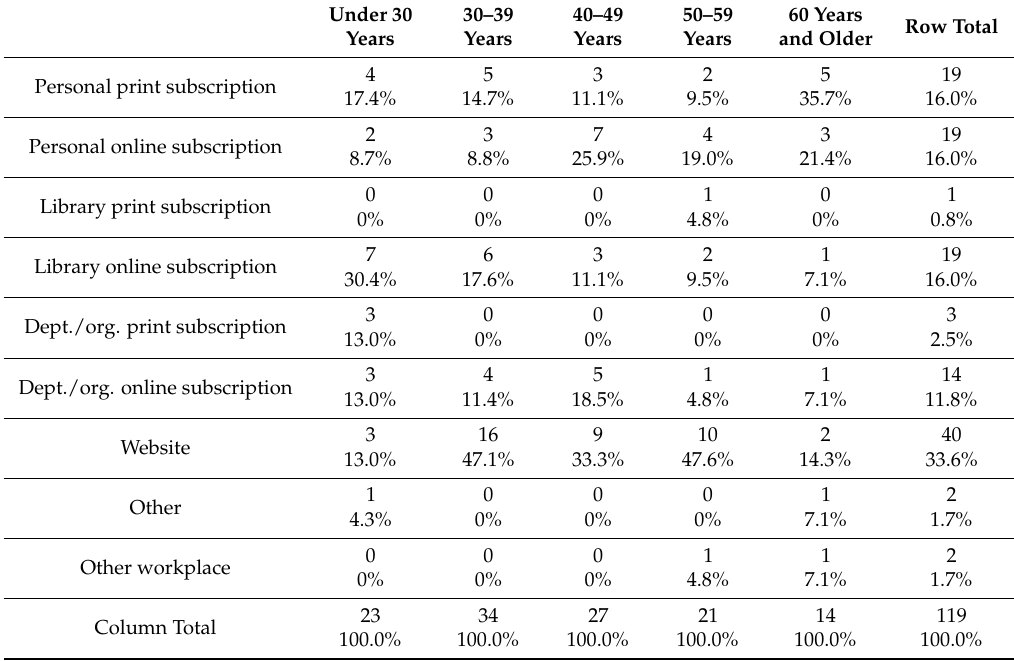
Table 16. Article browsing patterns by age